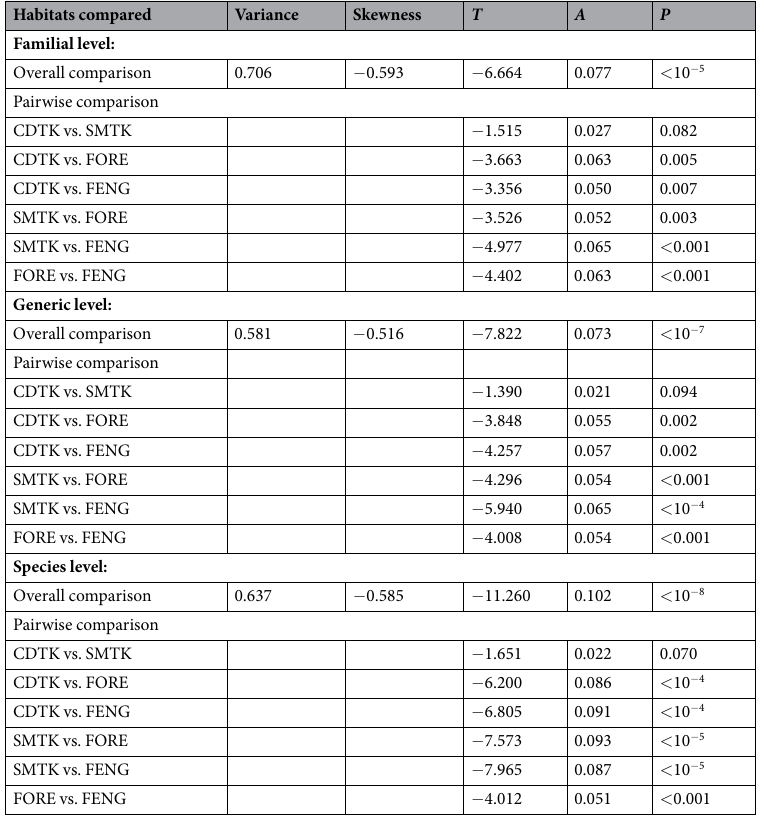
Table 2. Multi-response permutation procedures (MRPP) for the taxonomic composition across habitats. Definitions of the MRPP statistics: A is a measure of effect size and represents the within-group homogeneity; T is a statistic describing the separation between the groups; and P is the P -value for significance test of homogeneity using permutation. Habitat code: CDTK = Chuandong Tiankeng; SMTK = Shenmu Tiankeng; FORE = Forest Remnants; FENG = Fengshui